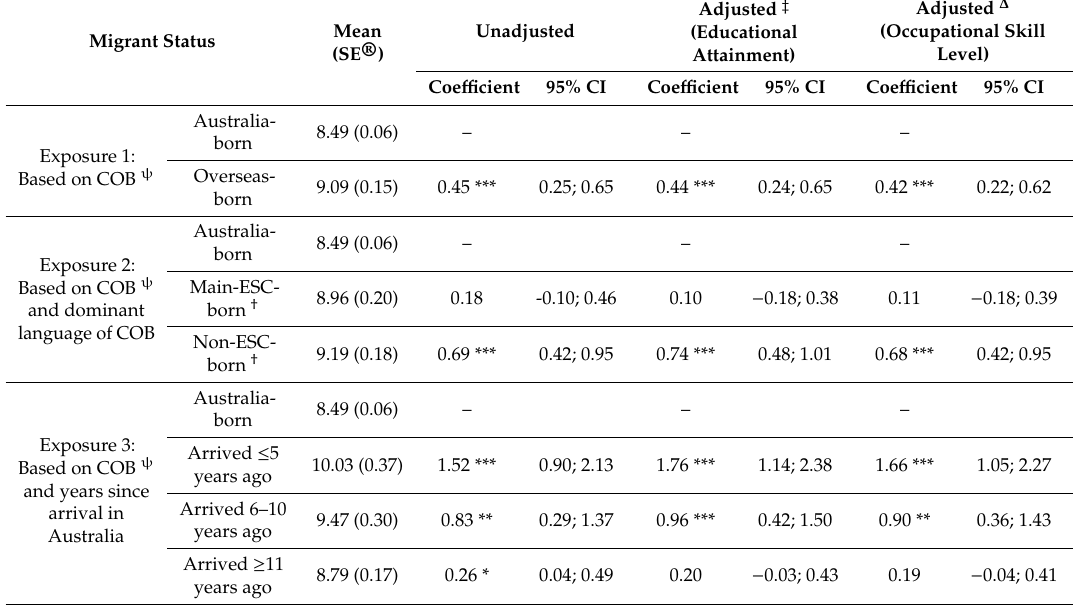
Table 2. Weighted mean and unadjusted and adjusted mean di ff erences in job insecurity between Australia-born and migrant workers ( n =